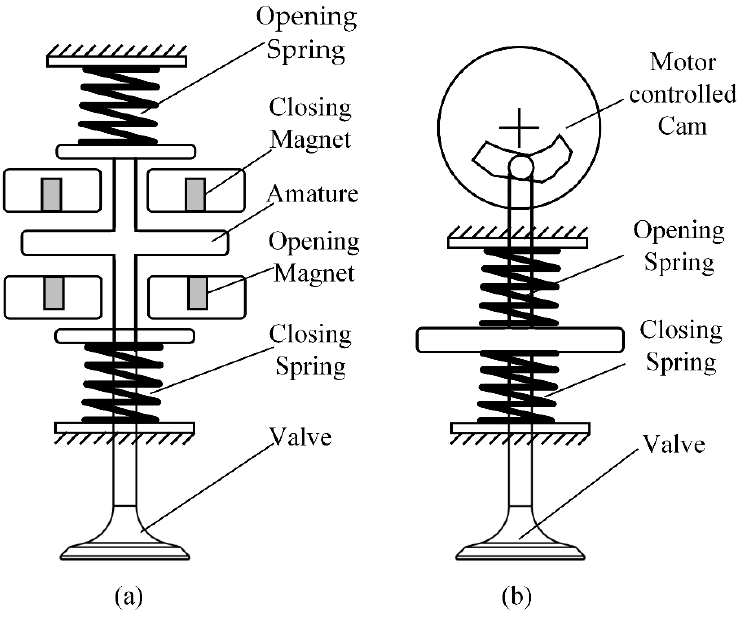
Figure 1. The electromechanical camless valve system: ( a ) Solenoid controlled ( b ) Motor controlled